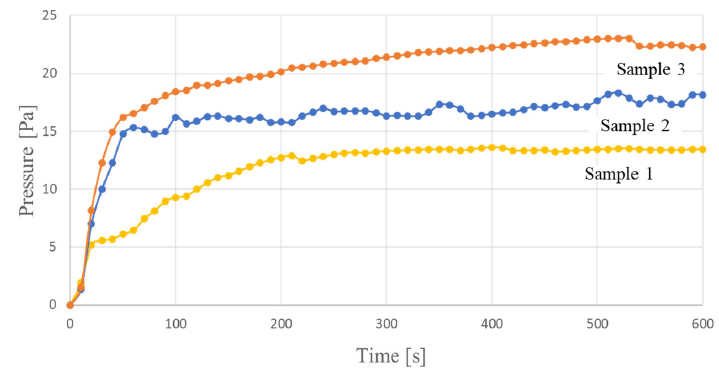
Figure 9. Difference in pressure with and without addition of carbon powder.